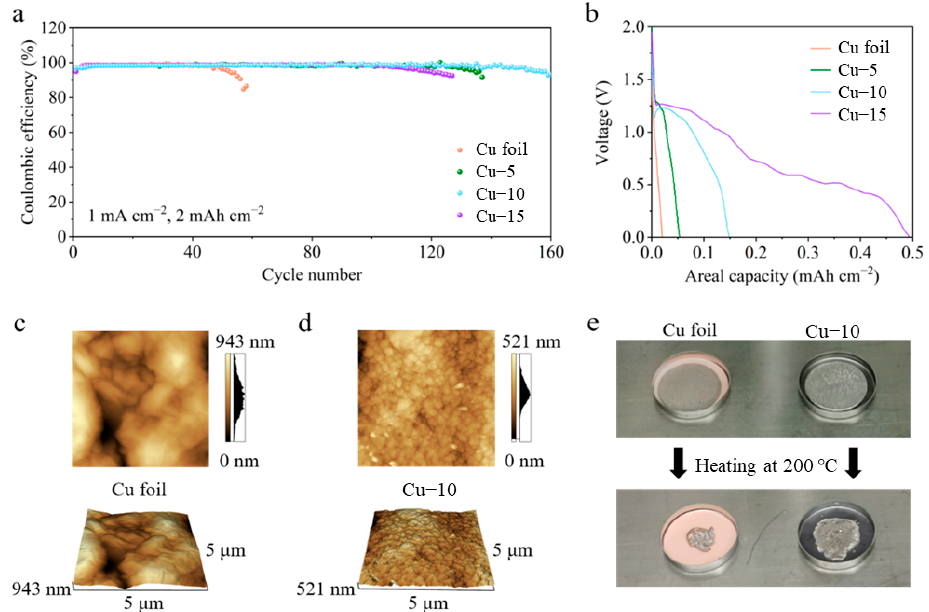
Figure 2. ( a ) Coulombic efficiency and ( b ) the first discharge profiles of the cells using the commercial Cu foil, Cu − 5, Cu − 10 or Cu − 15. AFM images of the ( c ) commercial Cu foil and ( d ) Cu − 10. ( e ) Optical photos of Li foil on the commercial Cu foil or Cu − 10 before and after heating at 200 °C.